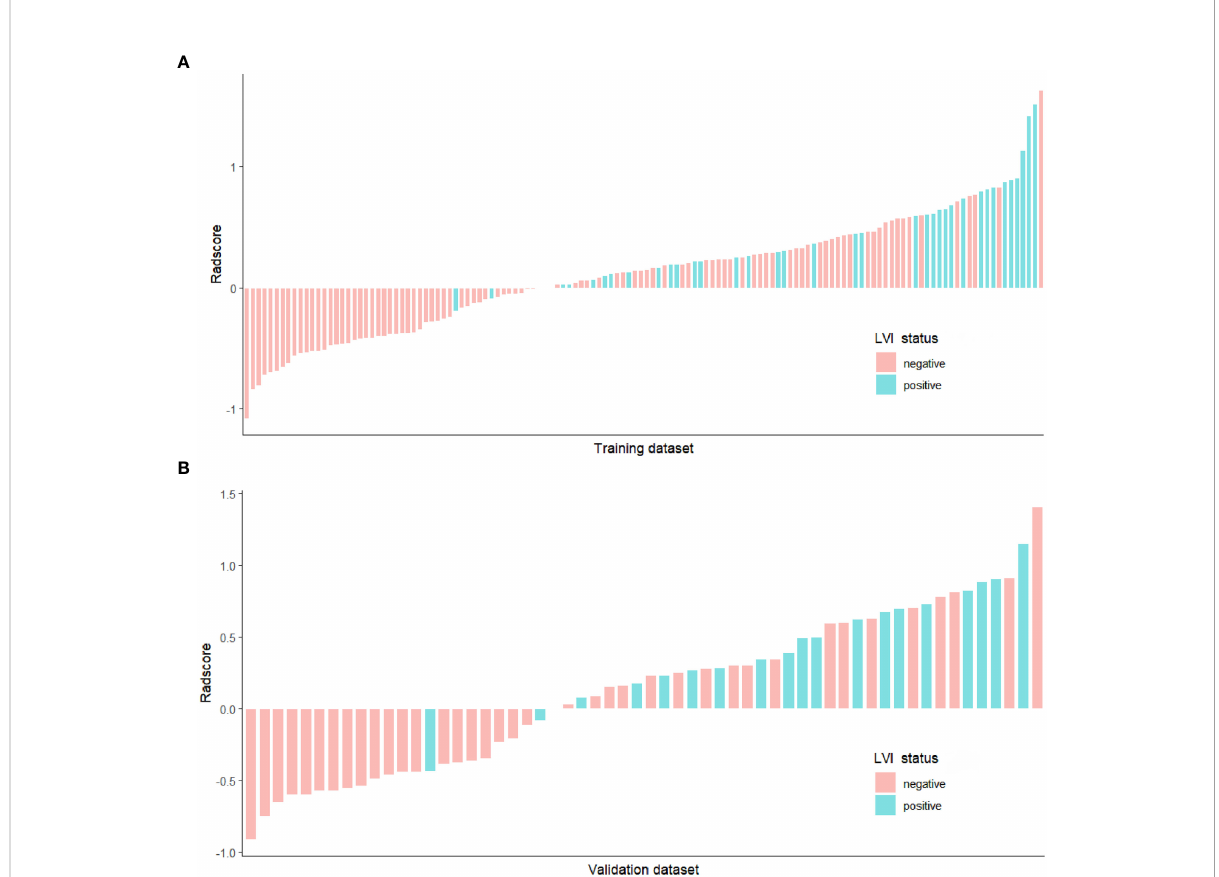
FIGURE 4 Bar chart of Radscore in the training (A) and validation (B) datasets, and the y-axis refers to the Radscore minus the cut-off value (i.e., Radscore +1.138). Up and down bars refer to the predicted positive LVI and negative LVI status, respectively. Green and red bars represent the actual LVI status as positive and negative, respectively.